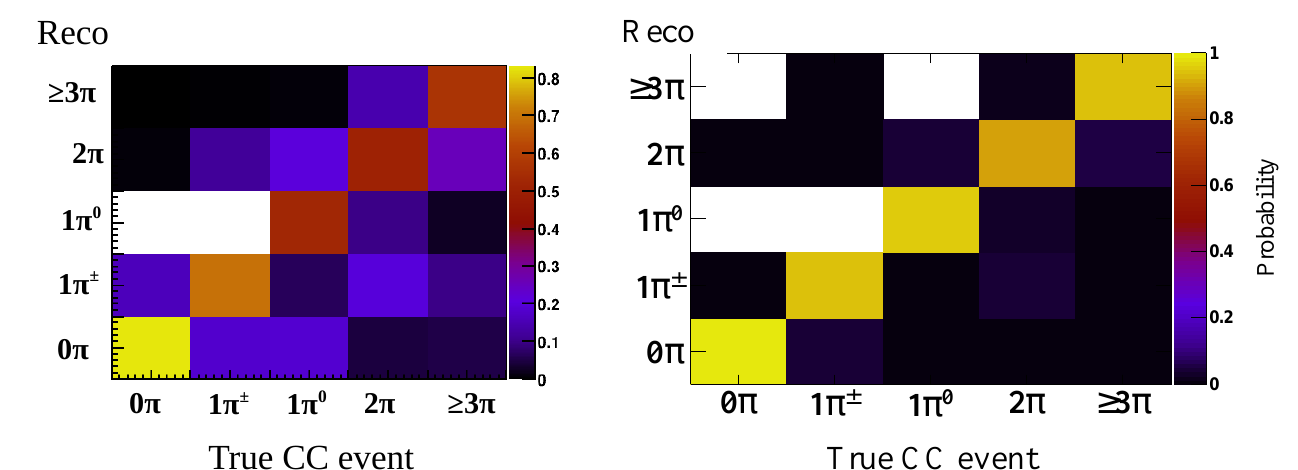
Figure 149. Confusion matrices showing the ability to correctly reconstruct states based on the number of pions in their final state, in the ND-LAr ( left ) and ND-GAr ( right ). No confusion has been observed for the combinations filled in white; black cells have some, if minimal, confusion.